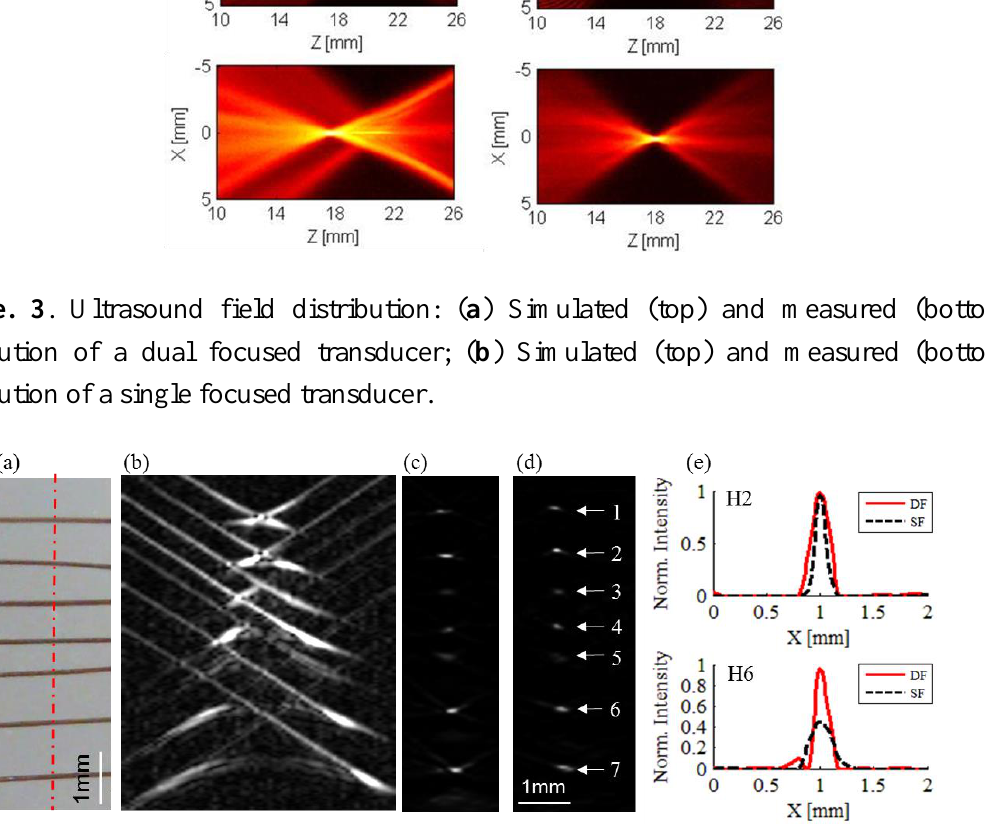
Figure 4. Photoacoustic microscopy (PAM) experimental validation. (a) photograph of a phantom sample vertically embed with 7 hairs; (b) B-scan PAM image obtained with dual-focused transudcer and reconstructed directly from original data; (c) B-scan PAM image obtained with dual-focused transudcer and processed with SADFT; (d) B-scan PAM image obtained with single-focused transducer and processed with conventional SAFT; (e) comparison of transects’ profiles at the 2 nd (DF FWHM=0.191 mm; SF FWHM = 0.124 mm) and 6 th (DF FWHM= 0.148 mm; SF FWHM =0.251 mm)) hairs. DF: